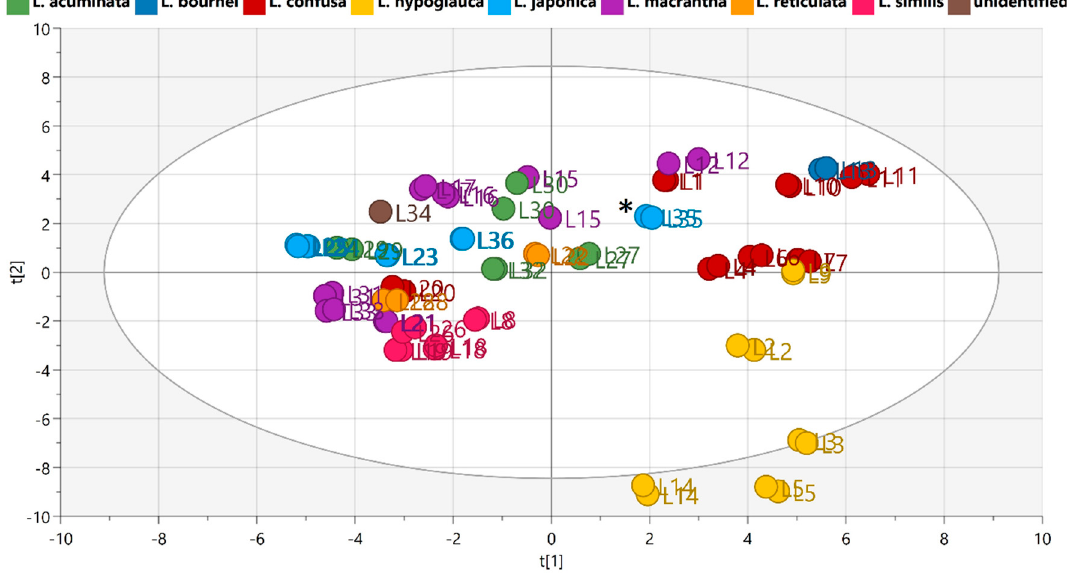
Figure 1. PCA score scatter plot [t1]/[t2] of preprocessed, normalized UHPLC-HRMS HESI-negative ion mode data (14 principal components: R2X (cum) = 0.796, Q2 (cum)= 0.519; R2X [t1]= 0.147, R2X [t2]= 0.126; Model window, see Supplementary Table S3). Samples are colored according to species: green = L. acuminata ; dark blue = L. bournei ; red = L. confusa ; yellow = L. hypoglauca ; light blue = L. japonica [*: samples L35_1 and L35_2, L. japonica flower bud extracts]; violet = L. macrantha ; orange = L. reticulata ; pink = L. similis ; dark brown = unidentified. Overall, the results of PCA indicated the broad phytochemical variability between and within the Lonicera species under